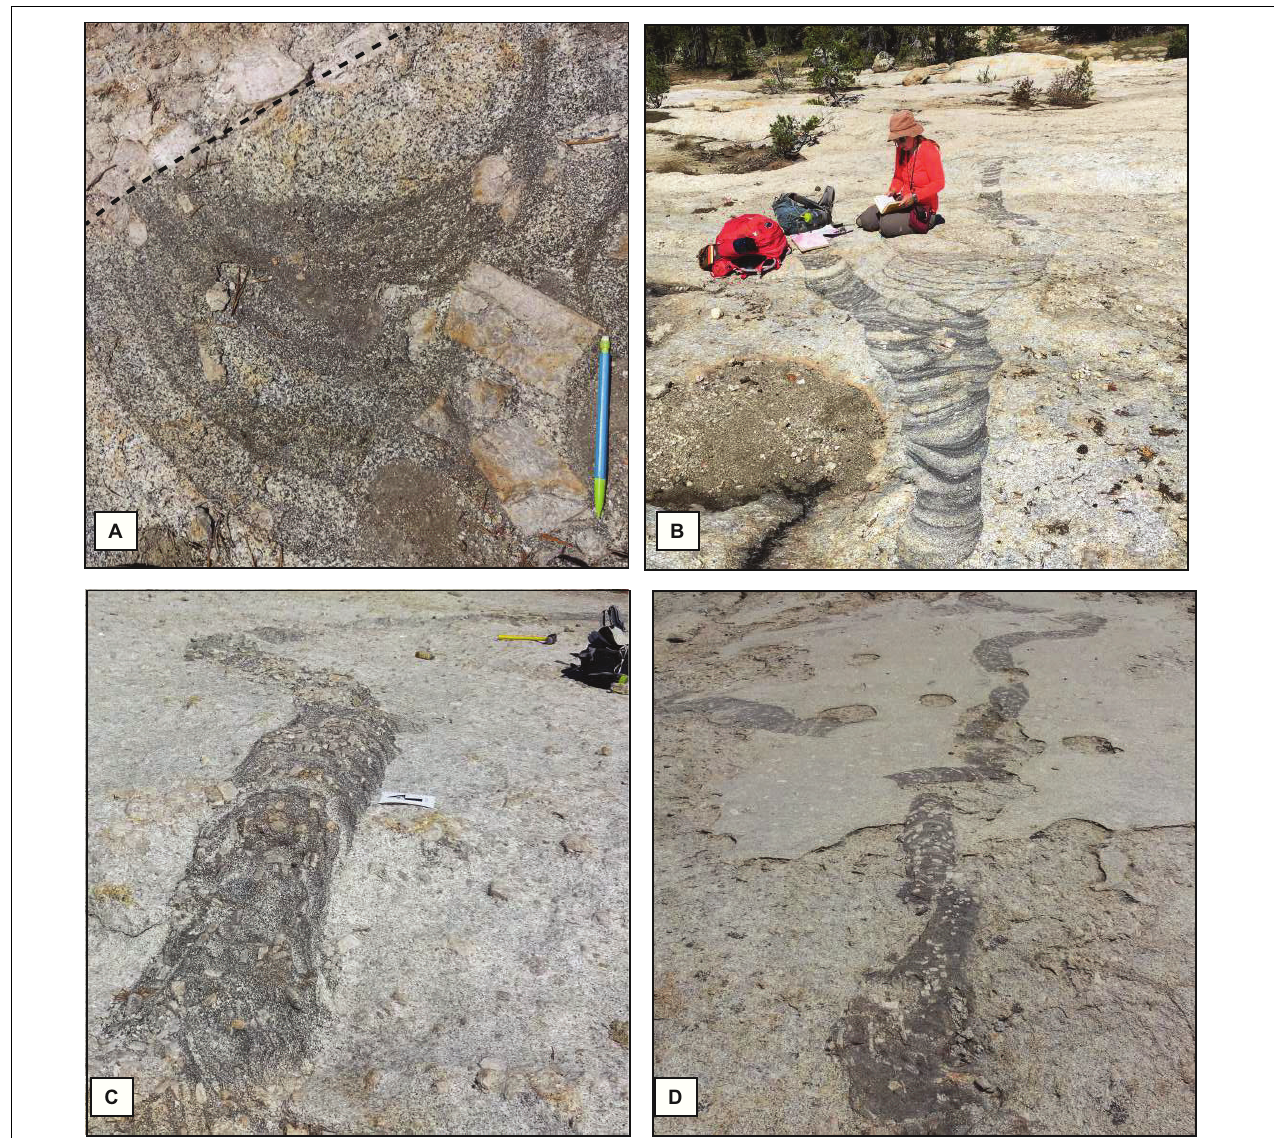
FIGURE 4 | Field photos of magmatic tubes. (A) Stationary tube truncated by host CP in the Glen Aulin area. Dashed line shows the contact where the tube is truncated by megacrystic CP. This tube contains at least 6 rings and unusually, the K-feldspar megacrysts within the structure are larger than the surrounding host megacrysts and also oriented at high angle to the schlieren rings. (B) Bifurcated migrating tube in the Glen Aulin area. This steeply dipping tube is ∼ 10 m in length, younging towards the field mapper. The diameter of the tube varies in size as it migrates, and in places is re-intruded by host CP. Photo from Paterson et al. (2018). (C) 6 m long migrating tube, migrating towards the bottom of the photo. These densely concentrated rings contain K-feldspar megacrysts. (D) 11 m migrating tube and 3 m migrating tube, Glen Aulin area. Segments of the longer tube have been re-intruded by host CP magma and rotated. The K-feldspar megacrysts align with the mafic minerals in the schlieren rings. Migration direction is towards the bottom of the photo (see also Hodge et al., 2012 for more information on this